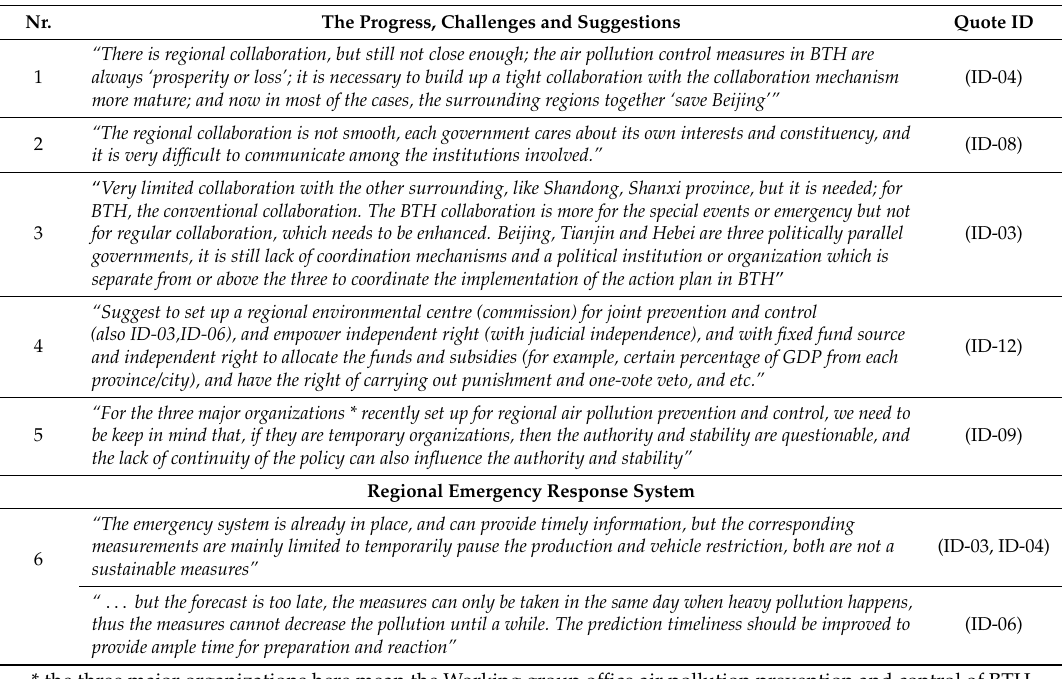
Table 3. Interview quotes in regional and institutional